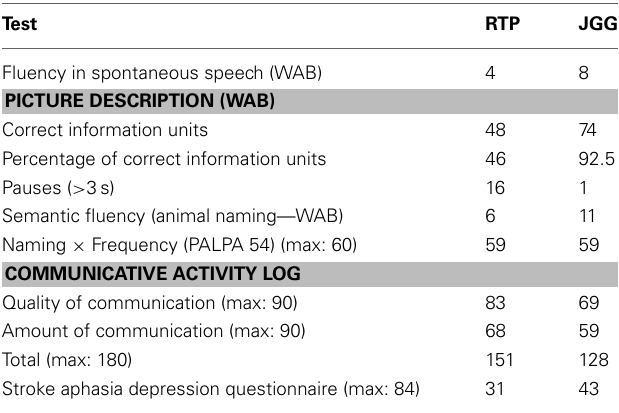
Table 1 | Language, communication, and